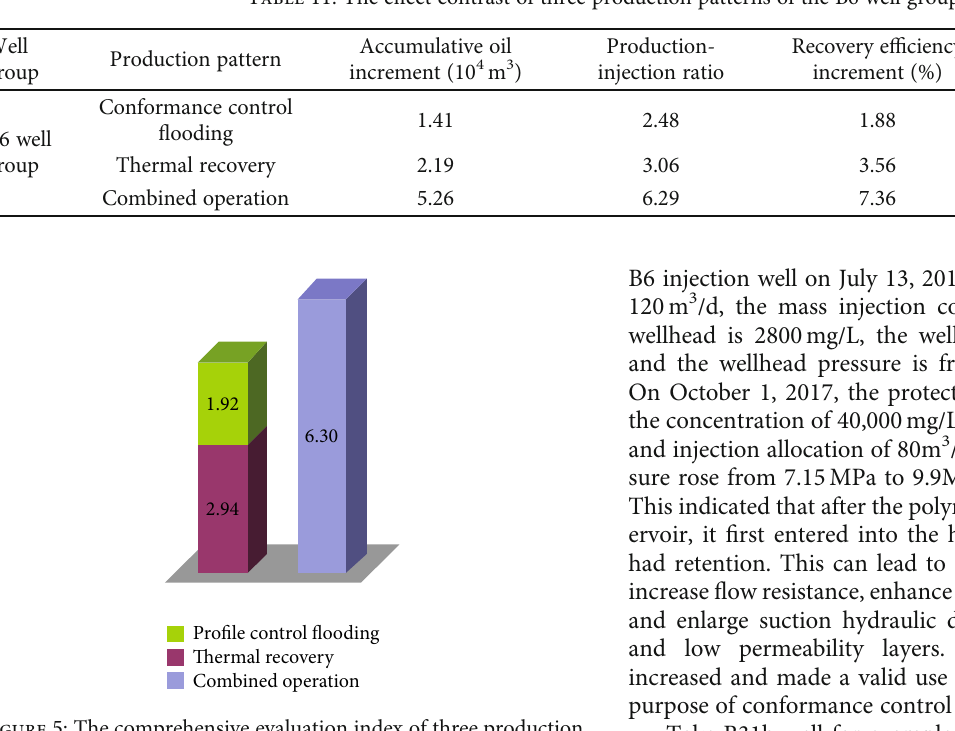
Table 11: The e ff ect contrast of three production patterns of the B6 well group.